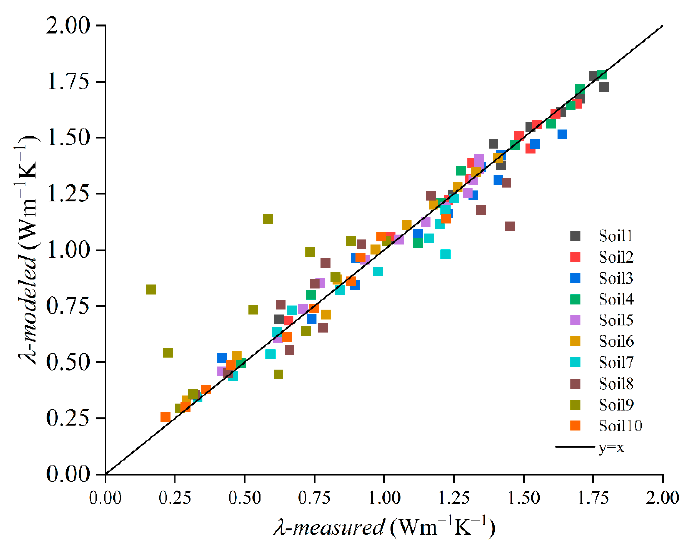
Figure 5. Comparison of predicted soil thermal conductivity ( λ ) values from the new model vs. measured data under the same water content of soils in Table 1.